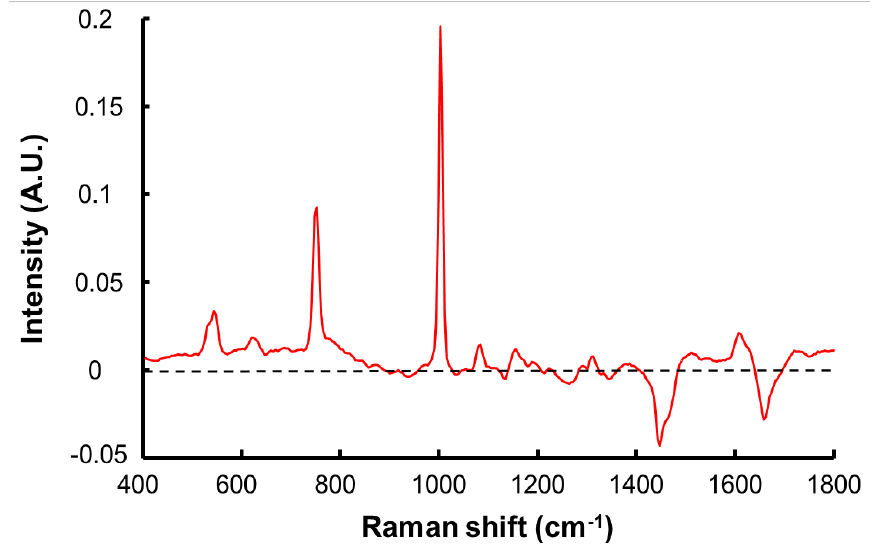
Figure 10. First regression coefficient from the PLSR analysis.